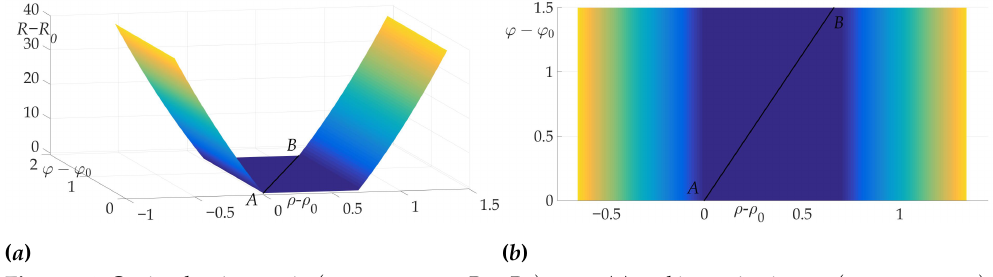
Figure 14. Optimal trajectory in ( ρ − ρ 0 , ϕ − ϕ 0 , R − R 0 ) space ( a ) and its projection on ( ρ − ρ 0 , ϕ − ϕ 0 ) plane ( b